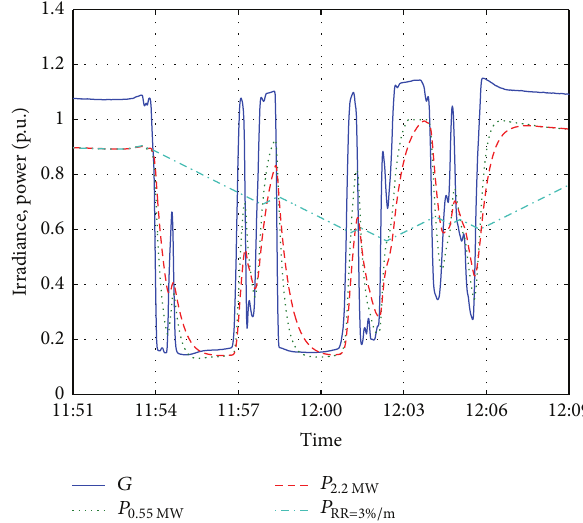
Figure 2: Measured point irradiance, simulated power of 0.55 and 2.2 MWpPVgenerators,andthegridfeed-inpowerofthe0.55 MWp PV generator complying RR limit of 3%/min during 18 minutes on 29.06.2012. Irradiance has been normalized to STC irradiance and power to the corresponding PV generator nominal